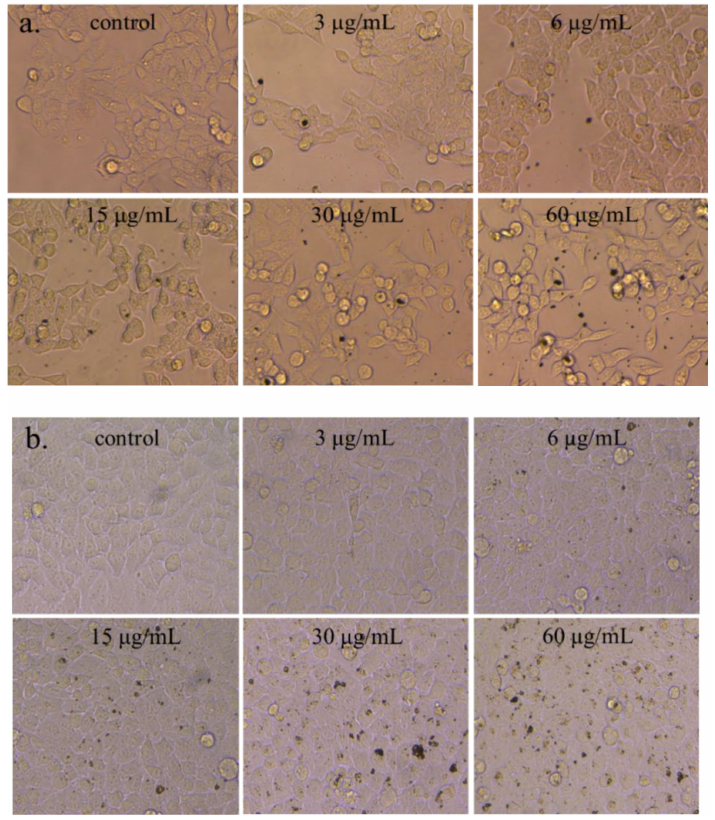
Figure 2. The morphology of two cells was observed after exposure to nano-Ag. ( a ) HCT116 cells; ( b ) NCM460